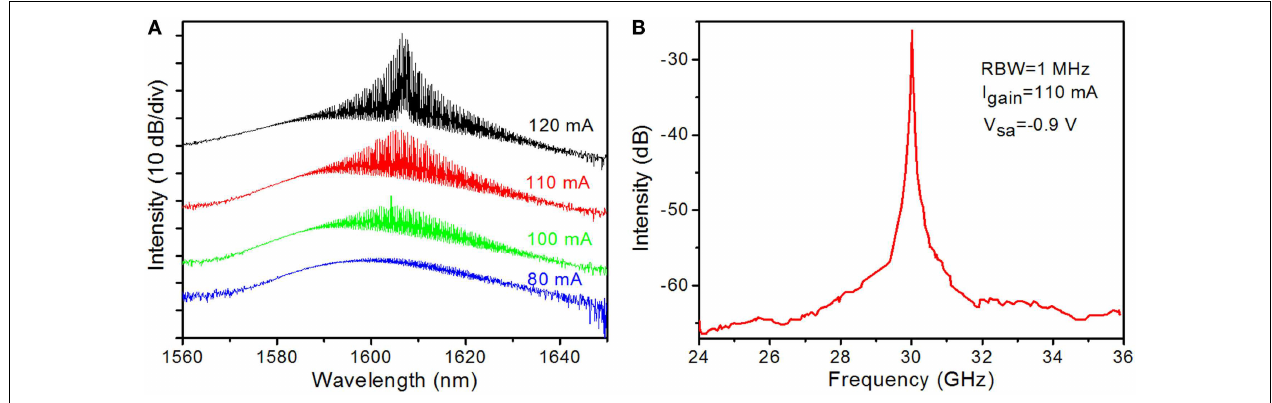
FIGURE 15 | (A) The measured optical spectra of the III/V-on-silicon mode-locked laser at different injection currents to the gain section while the SA section is floating. (B) Measured RF spectrum of the III/V-on-Si MLL at 110mA injection current and saturation voltage of − 0.9V.The RBW during measurement is